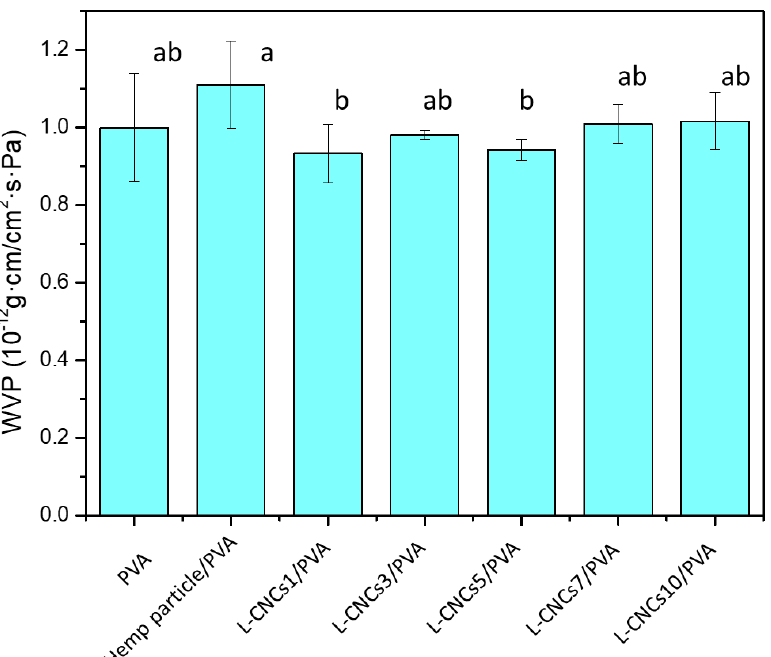
Figure 11. The water vapour permeability of pure PVA, hemp particle/PVA, and 5 wt.% L-CNCs/PVA film. Error bars indicate the standard deviation of samples. Different superscript letters (a, b) represent statistically significant differences among groups ( p ≤ 0.05); the superscript letters ab means no significant difference between ab and a or ab and b.